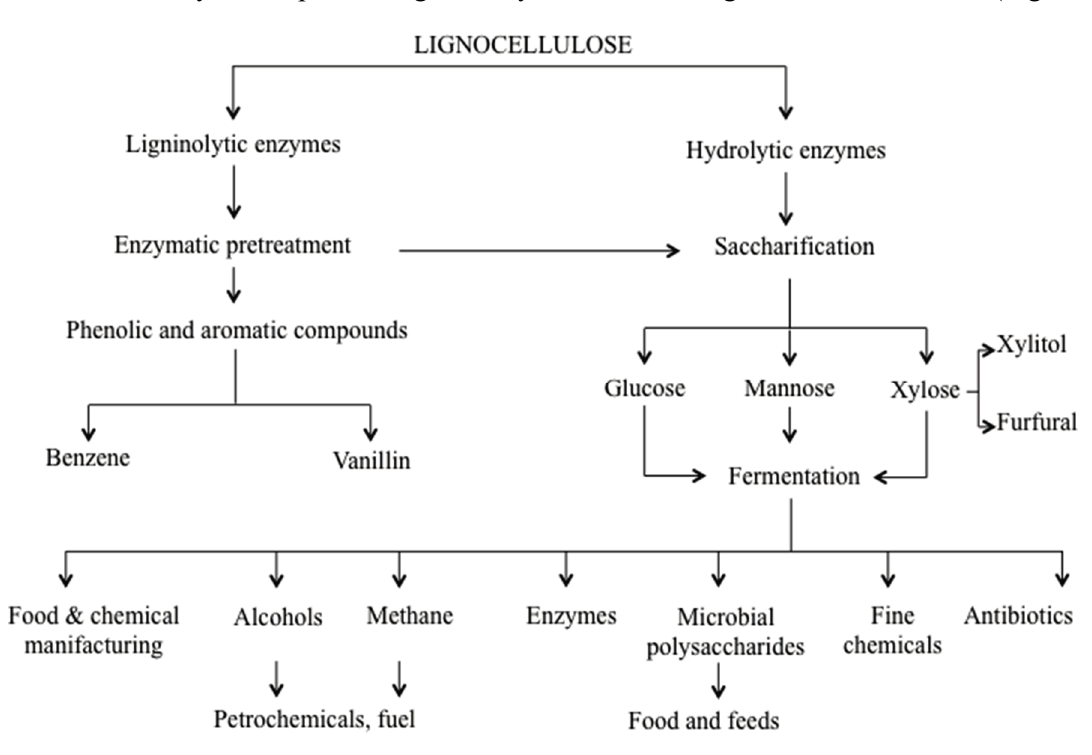
Figure 1. Lignocellulose bioconversion steps taken by fungal lignocellulose degrading enzymes. Lignocellulose is the most abundant, virtually inexhaustible, renewable carbon